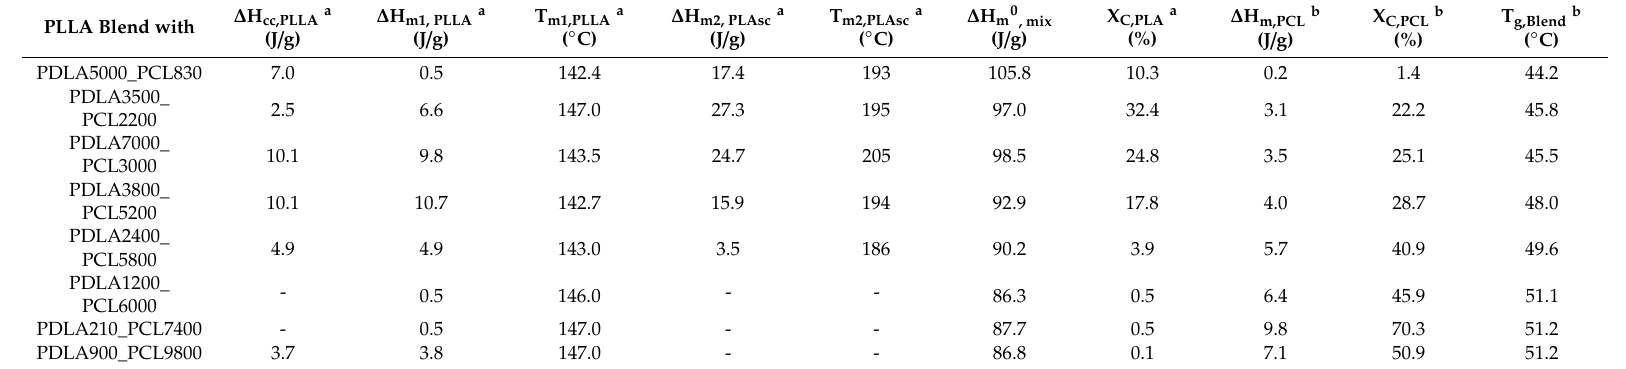
Table 4. Thermal properties of blends of PLLA and PDLA-PCL block